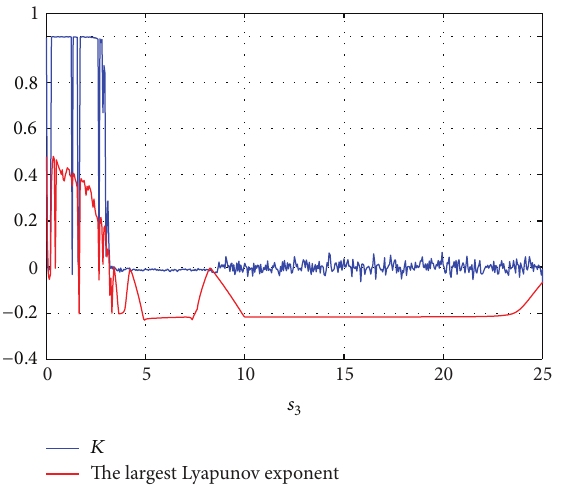
Figure 11: 𝐾 and the largest Lyapunov exponent versus 𝑠 2 ∈ [0, 25] and 𝑠 3 = 0.4 .